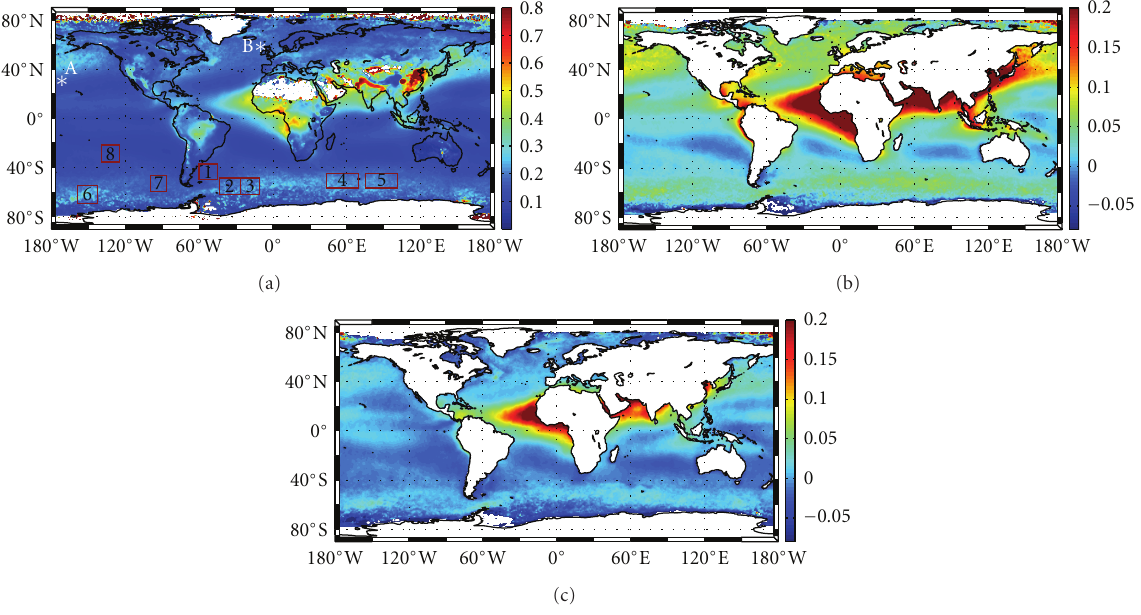
Figure 4: Seven-year (2002–2008) averaged daily data for (a) MODIS AOD at 550 nm and the di ff erences between MODIS AOD and parameterized ss-AOD at (b) 550 nm and (c)1020 nm. The ss-AOD is calculated using Smirnov et al. [57] regression. Red boxes on Figure 4(a) indicate seven regions where time series analyses are carried out. Position of each boxes (latitude and longitude) are given in Table 4. Letters A and B denote locations of previous study areas of Smirnov et al. [57] at Midway Islands (28.2 ◦ N and 177.4 ◦ W) and Mulchay et al. [58] at the Mace Head station (53.3 ◦ N, 9.9 ◦ W), respectively. The study region of Glantz et al. [59] encompassed large areas of the North Pacific Ocean, roughly from 180 ◦ W to 160 ◦ W and 15 ◦ N to 45 ◦ N.